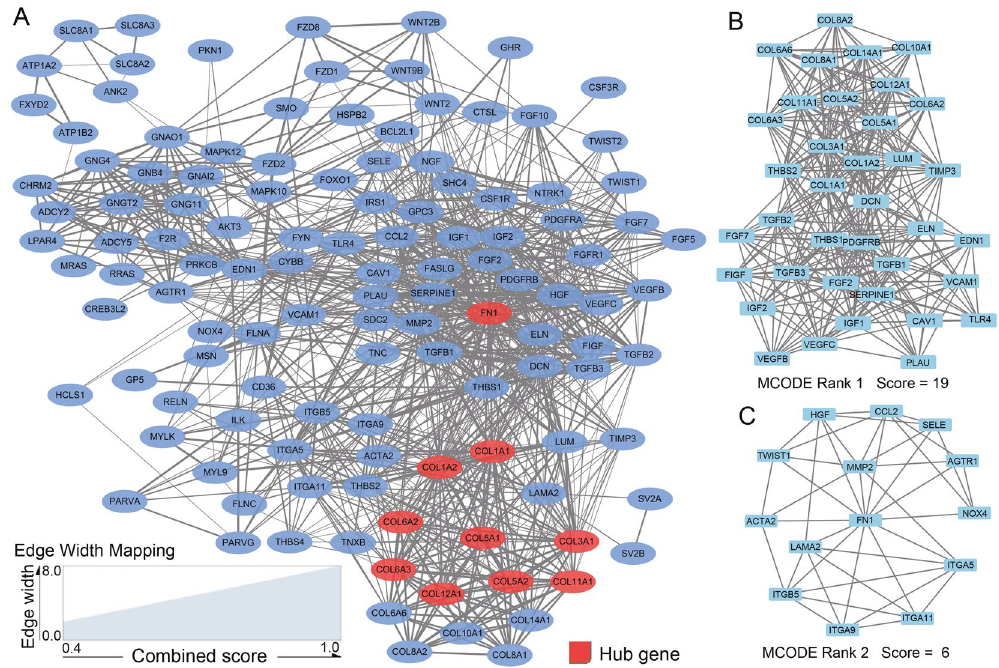
Figure 5. PPI network analysis. ( A ) The PPI network of DEGs enriched in the 7 KEGG pathways involved with collagen genes and the top 10 hub genes identified by cytohubba using the MCC method in Cytoscape. Three disconnected nodes were hidden in the network. ( B , C ) The top 2 clusters identified by MCODE in